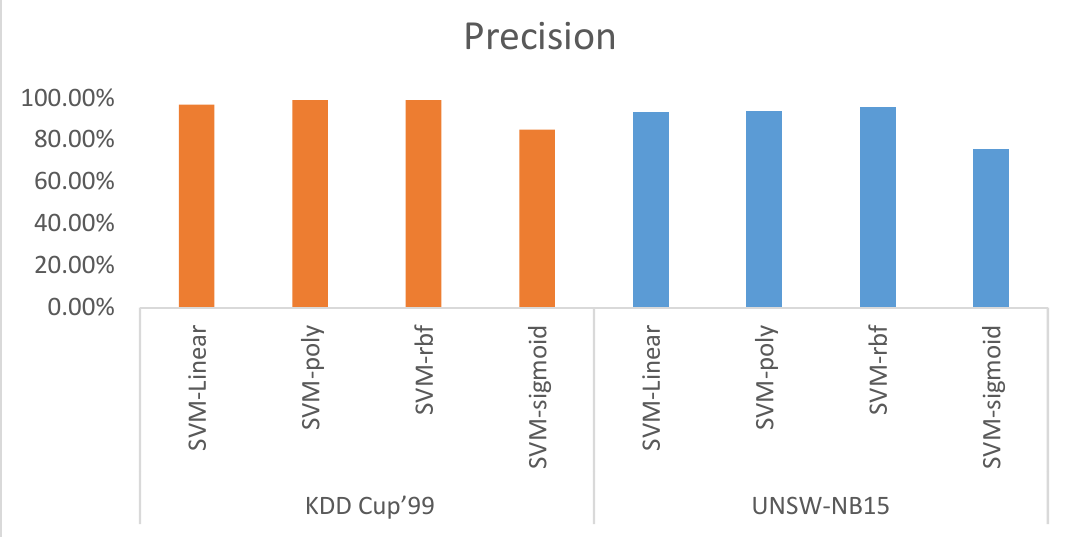
Figure 8. Precision.